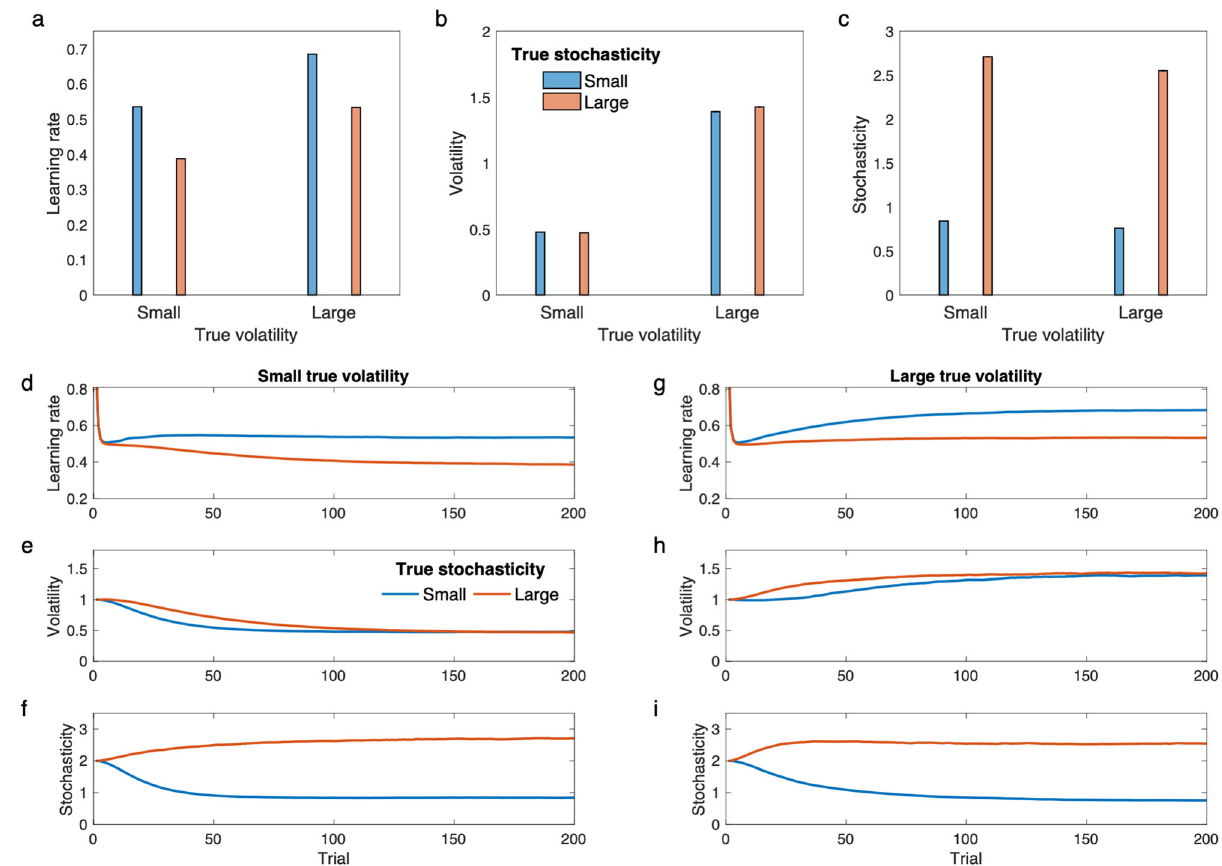
Fig. 2 Performance of the model in task with constant but unknown volatility and stochasticity parameters. Outcomes were generated according to the same procedure and parameters as those used in Fig. 1 (see Fig. 1a, b, e.g., outcome time-series seen by the model). a Learning rate in the model varies by changes in both the true volatility and stochasticity. Furthermore, these parameters have opposite effects on learning rate. In contrast to volatility, higher stochasticity reduces the learning rate. b Estimated volatility captures variations in true volatility. c Estimated stochasticity captures variations in the true stochasticity. In a – c , average learning rate, estimated volatility and stochasticity in the last 20 trials were plotted over all simulations. d – f Learning rate, volatility and stochasticity estimates by the model for small true volatility. g – i The three signals are plotted for the larger true volatility. Estimated volatility and stochasticity by the model capture their corresponding true values. Errorbars are standard error of the mean computed over 10,000 simulations and are too small to be visible. See also Supplementary Fig. 3 for further simulation analysis. Source data are provided as Source Data fi